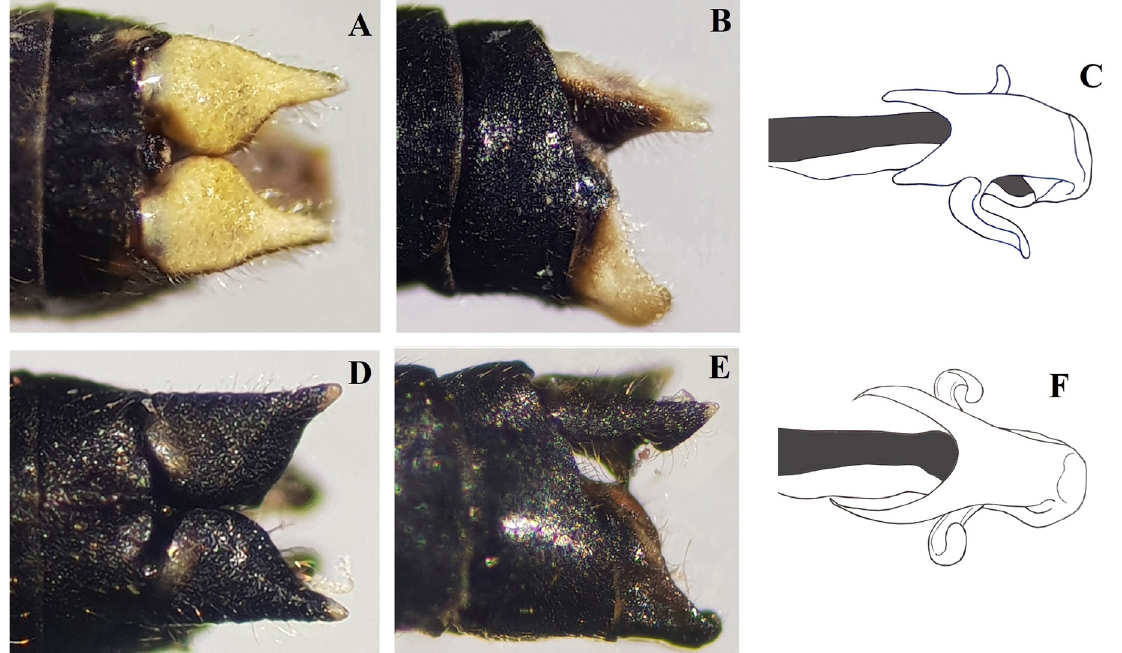
Fig. 7. Prodasineura Cowley, 1934 spp., males. A–C . P. croconota , ZCDTU 2017060802-ODO. D–F . P. verticalis Selys, 1860, ZCDTU 2018030611-ODO. A, D, G = tip of abdomen, dorsal view; B, E = tip of abdomen, lateral view; C, F = genital ligula, oblique-ventral view. Images not to